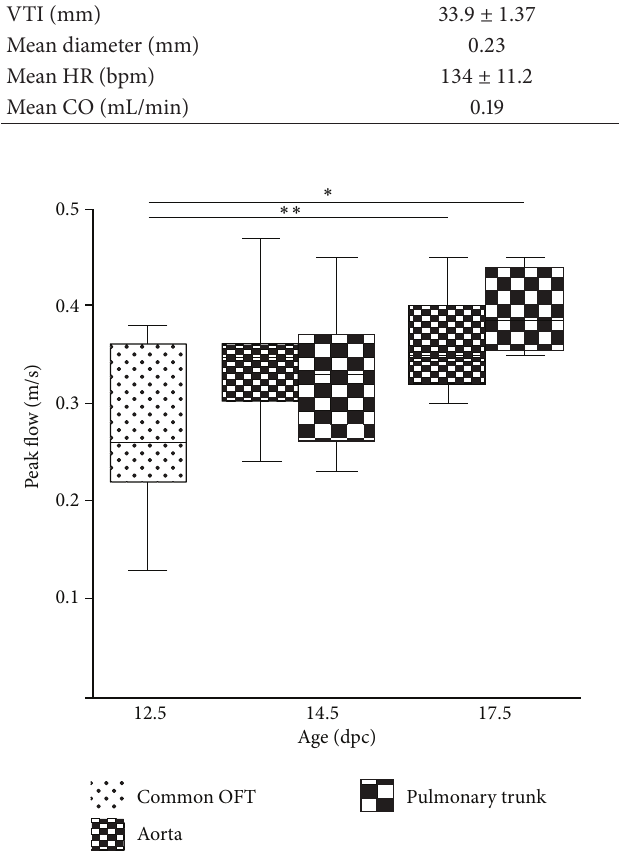
Figure 4: Pulsed-wave Doppler flow measurements in the cOFT, Ao, and PT. The graph demonstrates the significant increase of the peak blood flow measured in the cOFT at 12.5 and Ao and PT at 14.5 and